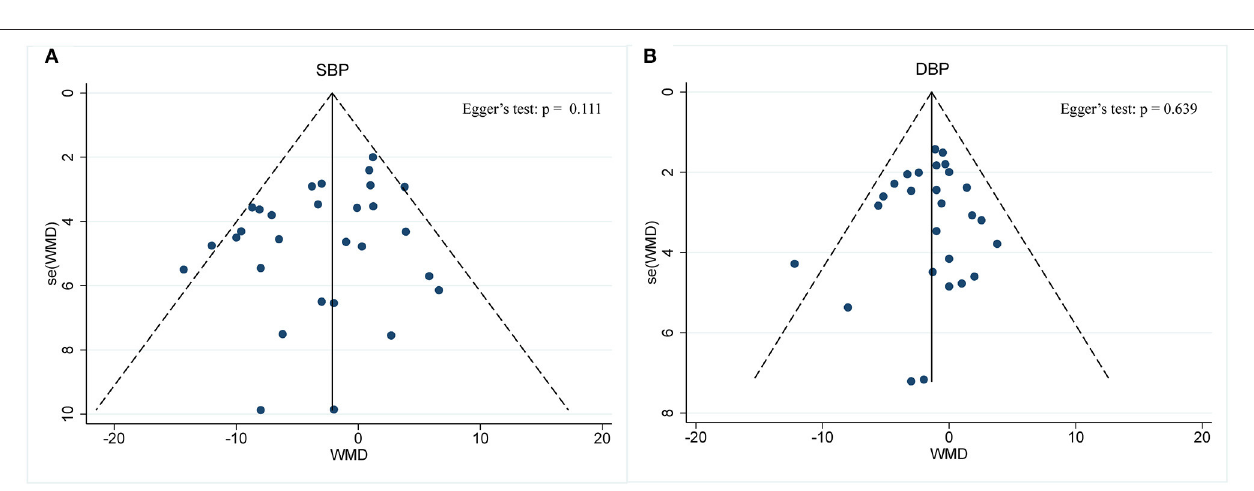
FIGURE 8 | Funnel plot displaying no publication bias in the studies reporting the impact of intermittent fasting on blood pressure (A) SBP and (B)